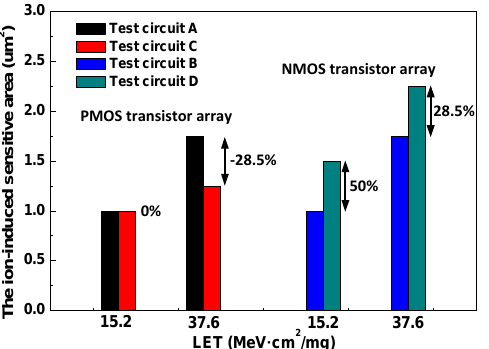
Figure 7. Effect of floating source regions on the measured ion-induced sensitive area with different LET values. Test circuit A and B have the normal connections of target transistors. The source regions of target transistors in test circuit C and D are floating.